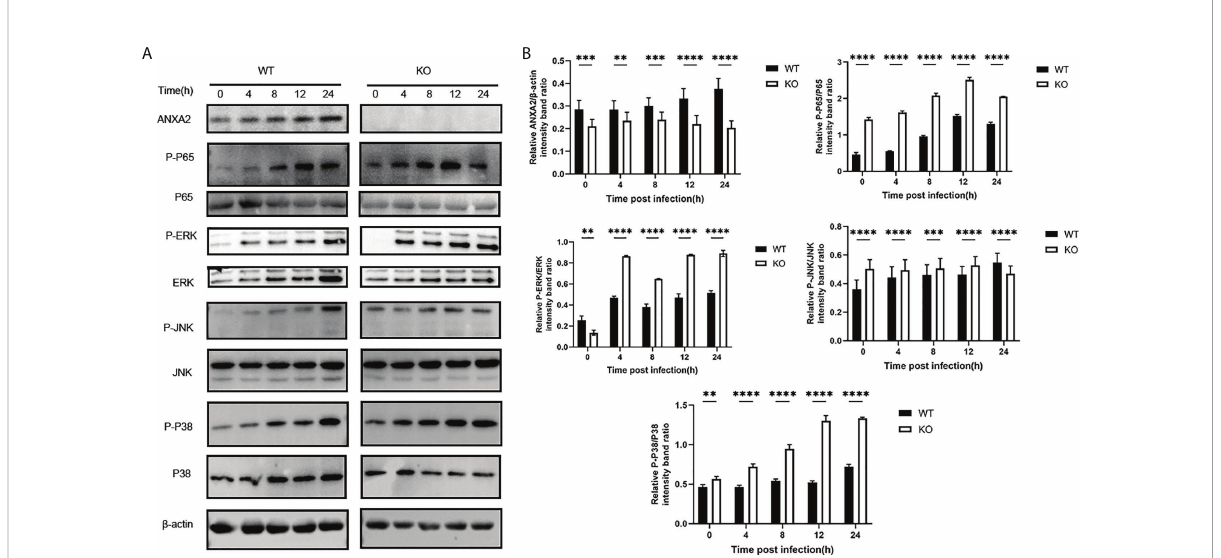
FIGURE 9 Knockout of ANXA2 exacerbates on the NF- k B and MAPK signaling pathways during M. bovis infection process. (A) ANXA2-KO EBL cells (KO) or wild-type EBL cells (WT) were infected with M. bovis for the indicated time points, and western blotting assay was performed to determine the protein levels of ANXA2 and unphosphorylated and phosphorylated signaling molecules. (B) The band intensities were quanti fi ed with ImagJ, and the relative ANXA2, phosphorylated-P65, phosphorylated-P38, phosphorylated-JNK levels are shown. The data from three independent